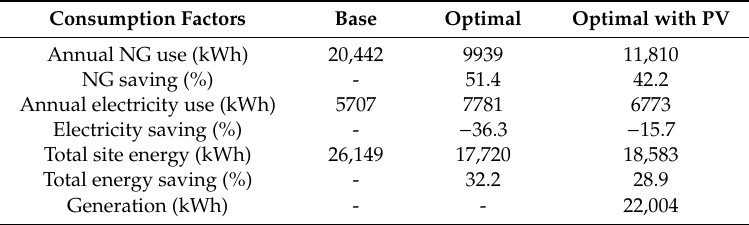
Table 13. The annual energy saving, consumption, and generation of the